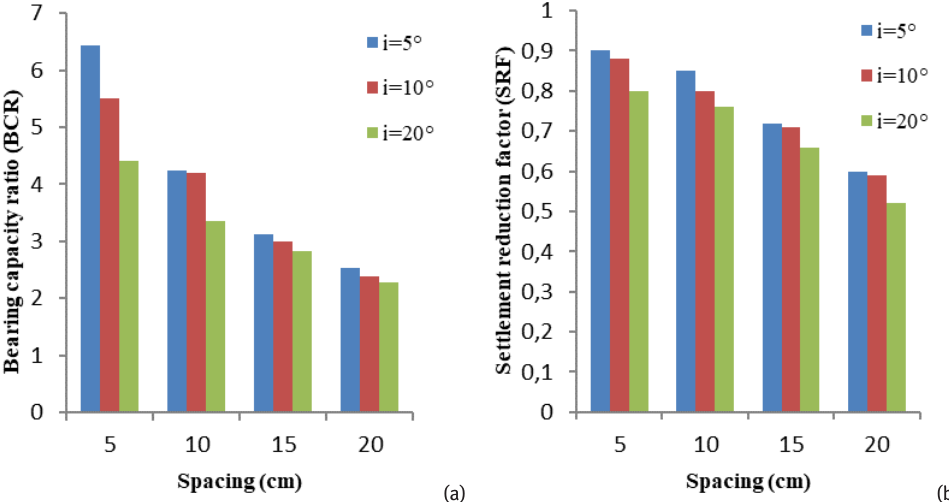
Figure 9: (a) Variation of bearing capacity ratio with spacing (b) variation of settlement reduction factor with spacing, at confiner dimension (D/B = 2.0; d/B =